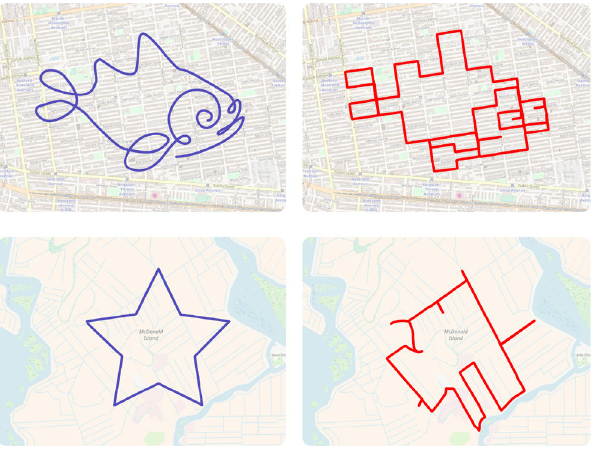
Fig. 11 Limitations of automated GPS art route generation. Top: an overly detailed figure placed within a checkerboard pattern where details get lost. Bottom: placing figures within rural areas with insufficient